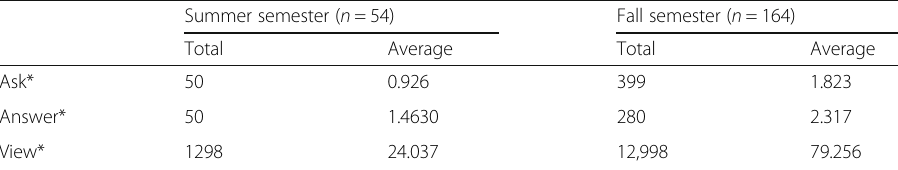
Table 1 Descriptive summary of frequency